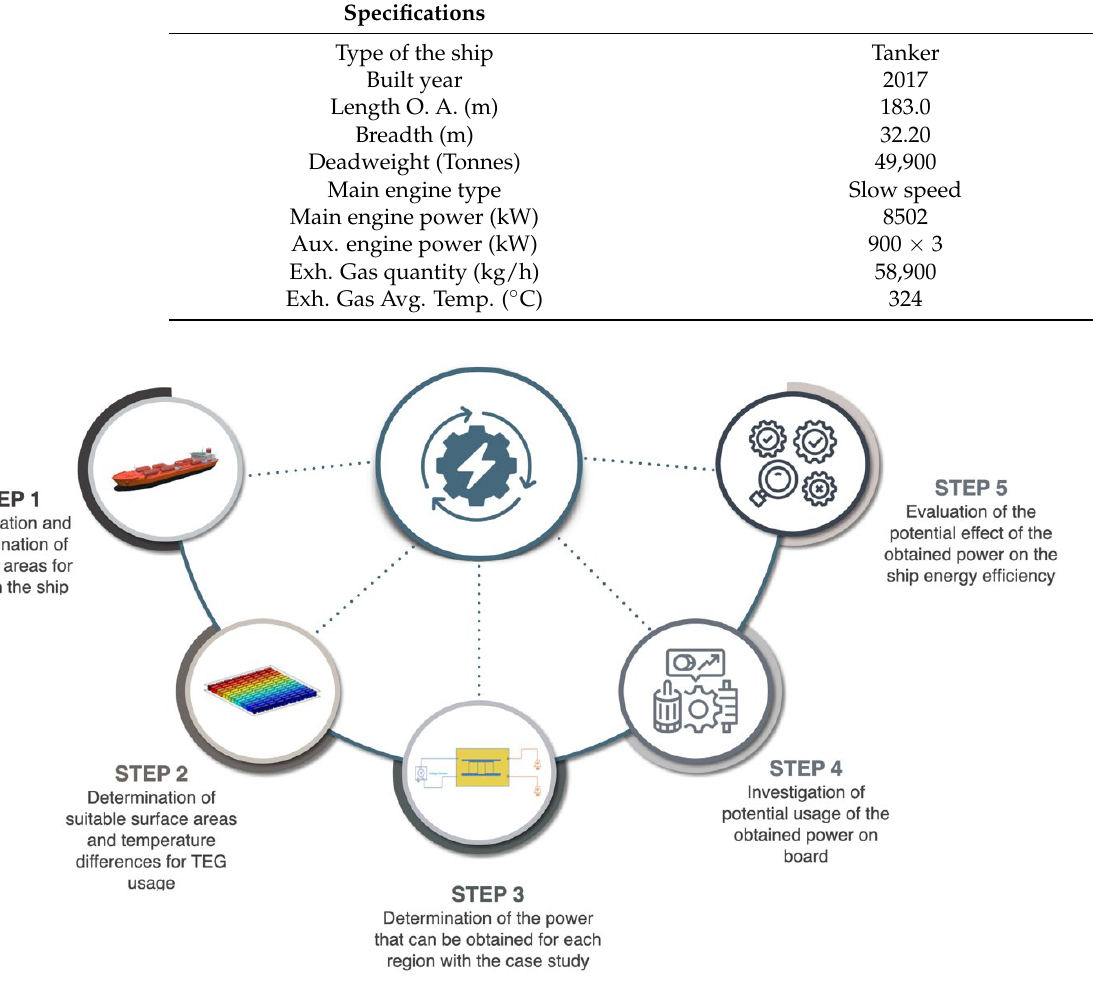
Table 1. The emission factors.